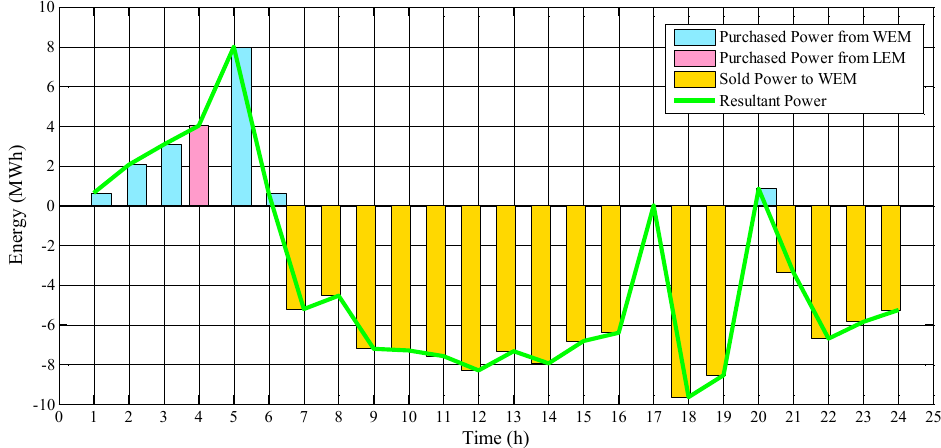
Figure 16. Changes in the Distributed Energy Resources (DER) Aggregator’s (AG’s) uncertain variables in scenario 6.